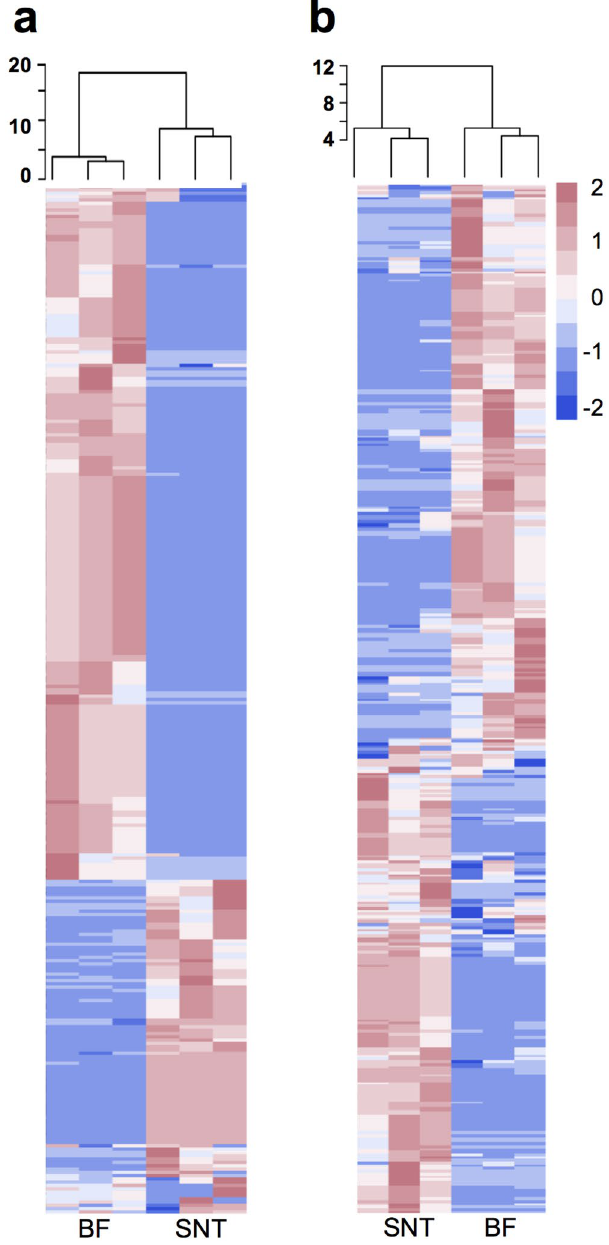
Figure 3. Heatmap representation of the molar abundance for the proteins detected in metasecretome experiment. Heatmaps show molar abundance of proteins that were detected in the biological replicates for ( a ) wheat straw (WS) and ( b ) rice straw (RS) compost communities. Vertical columns represent each biological replicate and the proteome fraction collected for analysis by LC-MS/MS: biotin-labelled (BF) and supernatant (SNT) fractions. Horizontal rows depict proteins identified in the metasecretome. The molar abundance values were centered, scaled in row direction (range from − 2 to 2) and used for hierarchical clustering of the samples by using Euclidean distance and average method. Approximately unbiased (AU) p -value was calculated via multiscale bootstrap (n = 1000) resampling using pvclust package in R and all the clusters were strongly supported by the data (AU > 0.95). Heatmaps were constructed using pheatmap package in